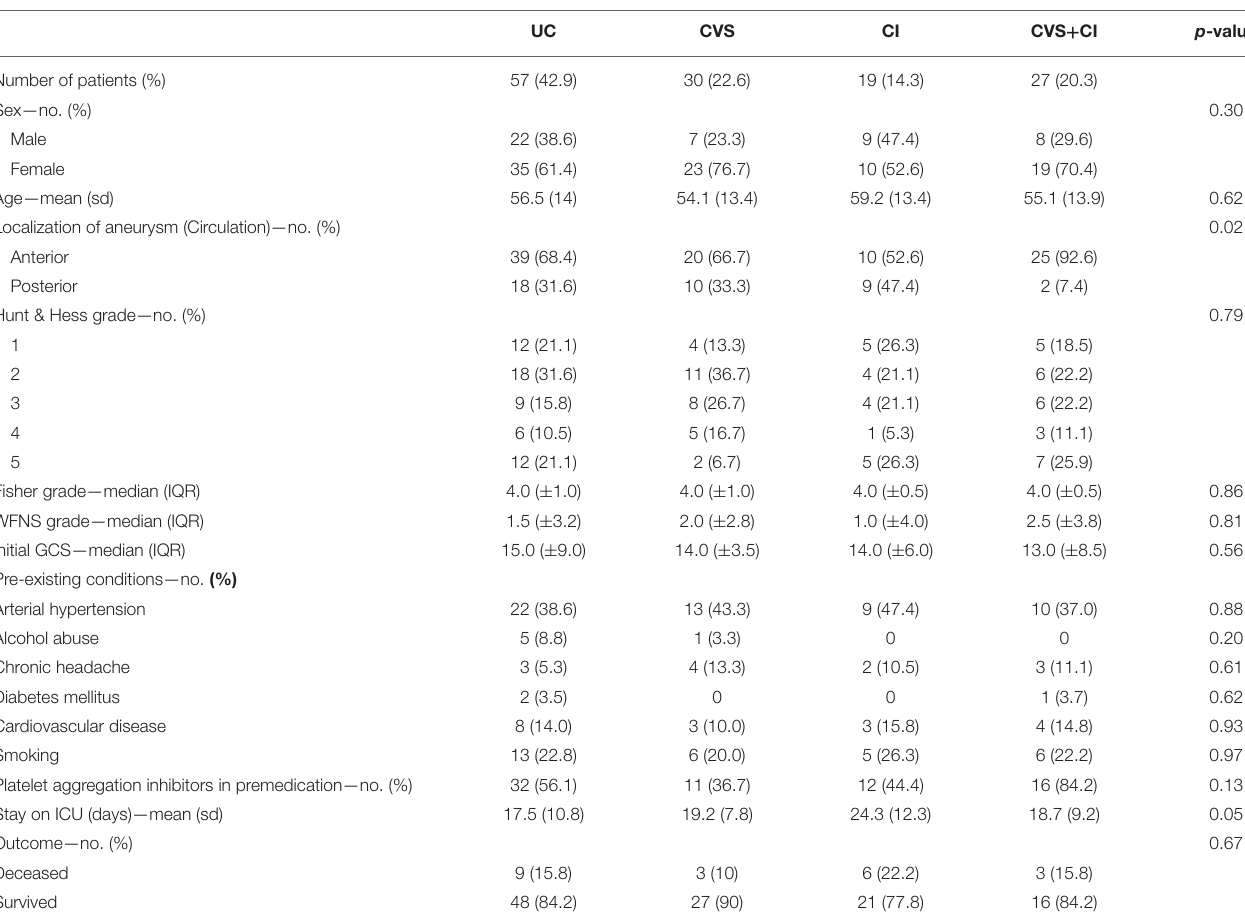
TABLE 1 | Patient